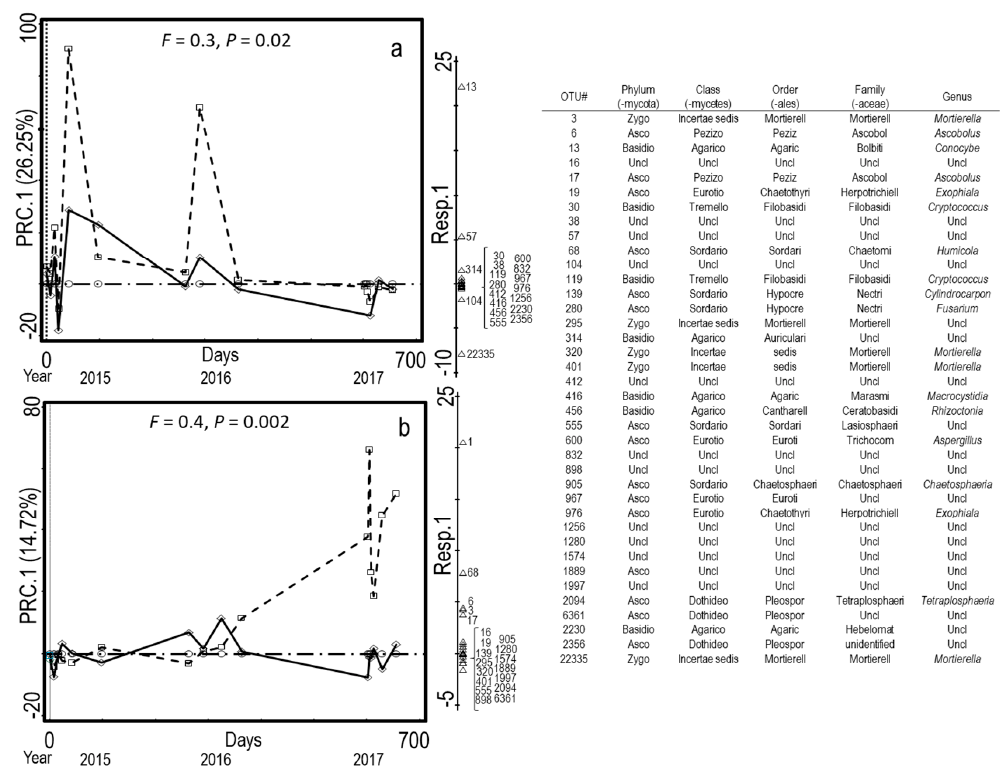
Figure 2. First principal response curve coefficient (PRC.1 with explained fitted variation in parentheses) of the ITS amplicon sequences for ( a ) Lilac and ( b ) Wheelock. Curves represent the deviation between a compost treatment (dashed: dairy manure; solid: poultry litter) from a non-amended control (dotted-dash) as a function of time, with 0 as the day of compost amendment in 2015 and the continuous calendar time until the end of 2017 season. Symbols mark the sampling times. The weights of the 25 best-fit OTUs are shown on the right axis. Missing taxonomic information occurs if a higher resolution was not available for the OTU (Unclassified: Uncl). Monte Carlo permutation tests permuting whole time series were applied to compute the statistical significance ( n = 137 for Lilac, 165 for Wheelock).